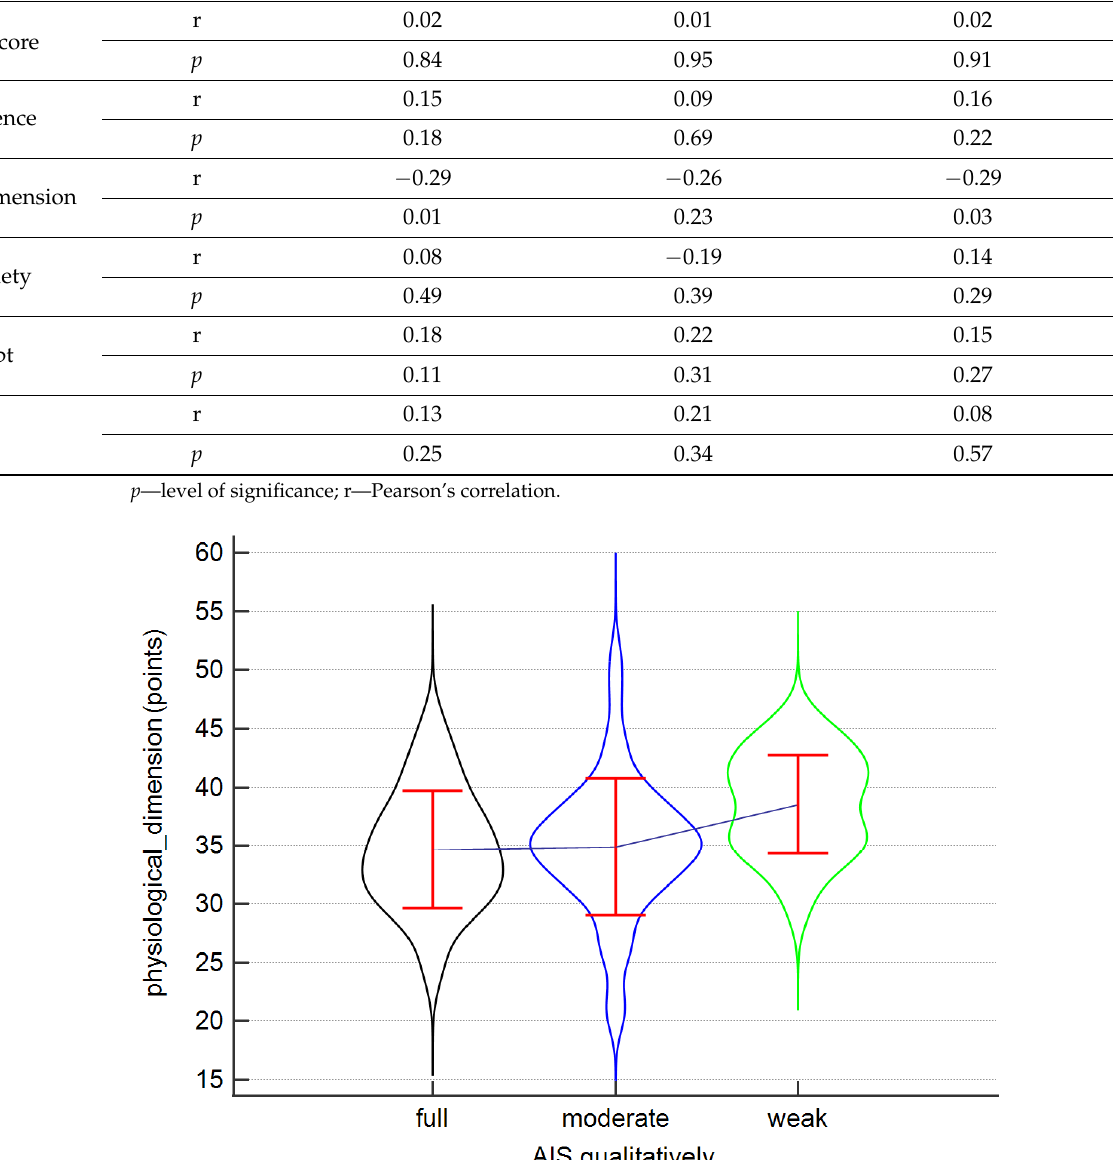
Figure 4. Correlation of age with CAPS subscales: coping ( A ) and physiological dimension ( B ) in all study participants.